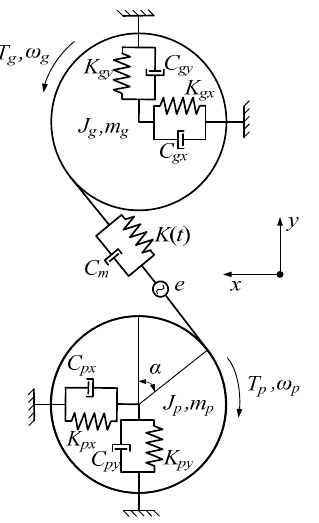
Figure 4. Dynamical model of spur gear system with six DOF.